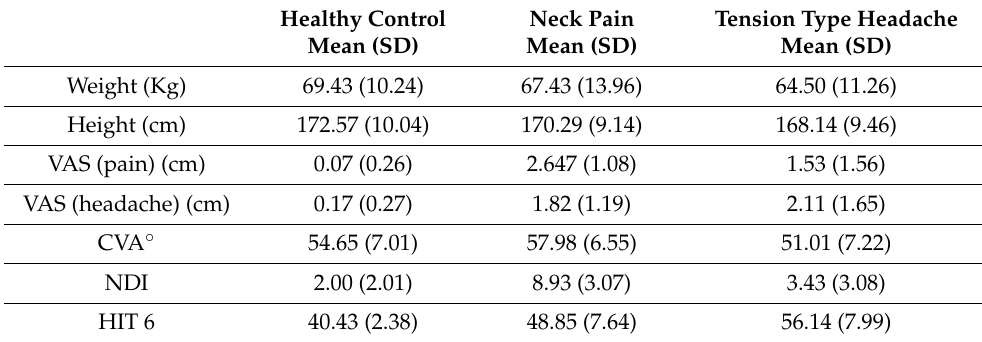
Table 1. Descriptive analysis of the demographic data.